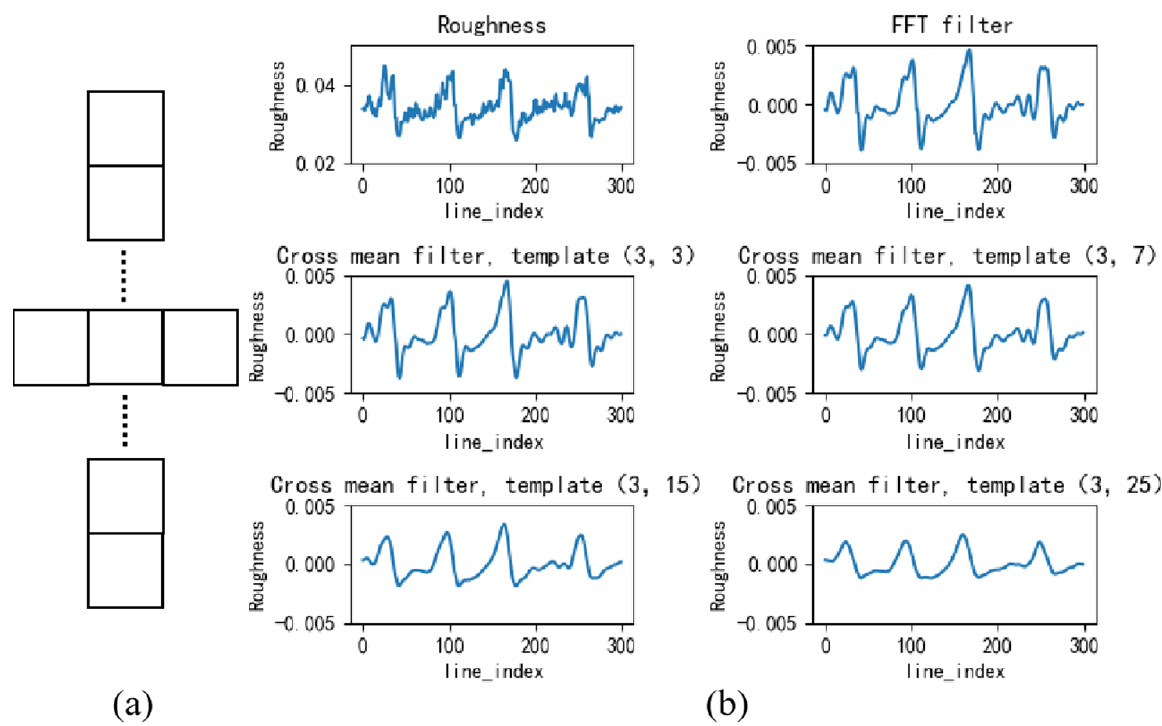
Figure 5. ( a ) Cross-filtered template and ( b ) original SSR on the profile line and filtered SSR.